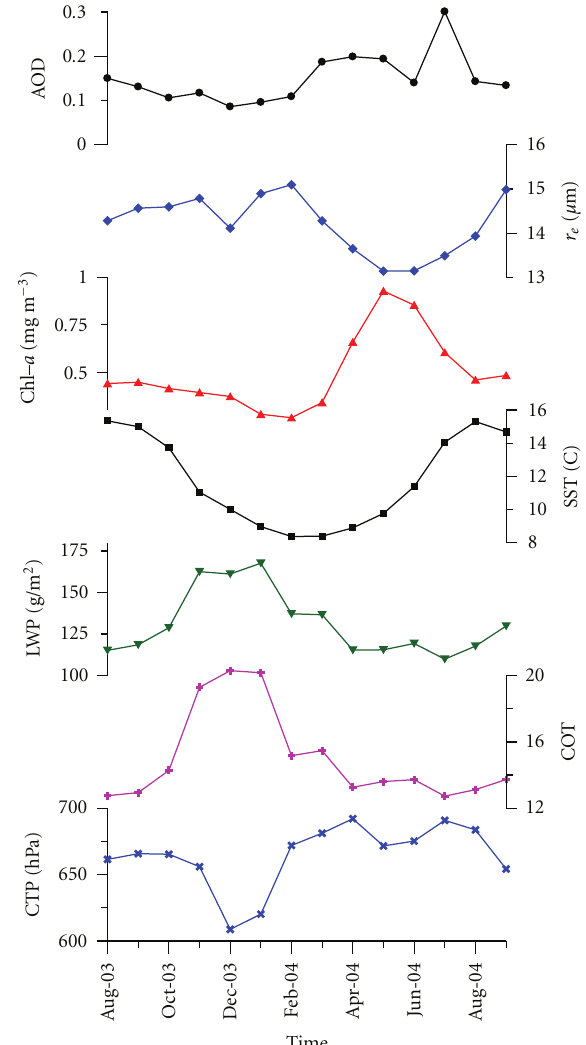
Figure 1: Time series of the area-averaged MODIS Aerosol optical depth (AOD), liquid cloud e ff ective radii ( r e ), sea surface temperature (SST), liquid water path (LWP), liquid cloud optical thickness (COT), liquid cloud top pressure (CTP) and SeaWiFS [Chl- a ] in Northwest Atlantic (42 ◦ N to 60 ◦ N and 55 ◦ W to 21 ◦ W).